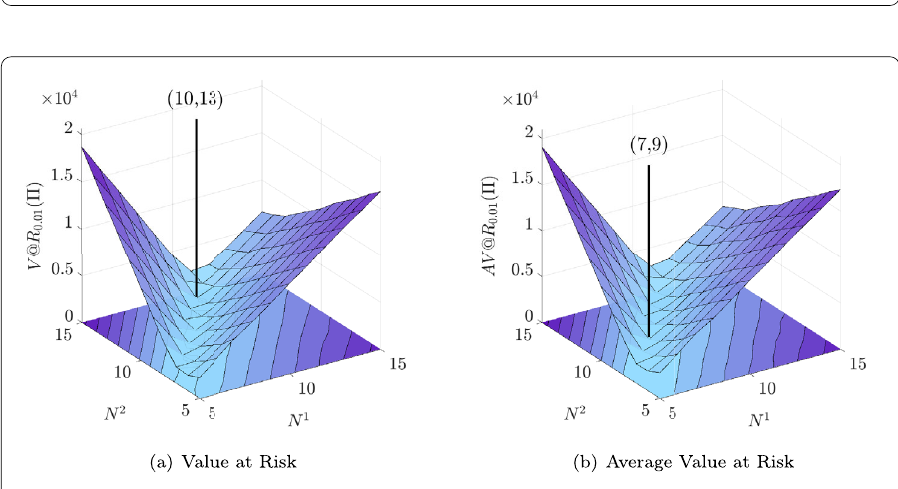
Figure 9 Value and Average Value at Risk for different cluster sizes and level λ = 0.1